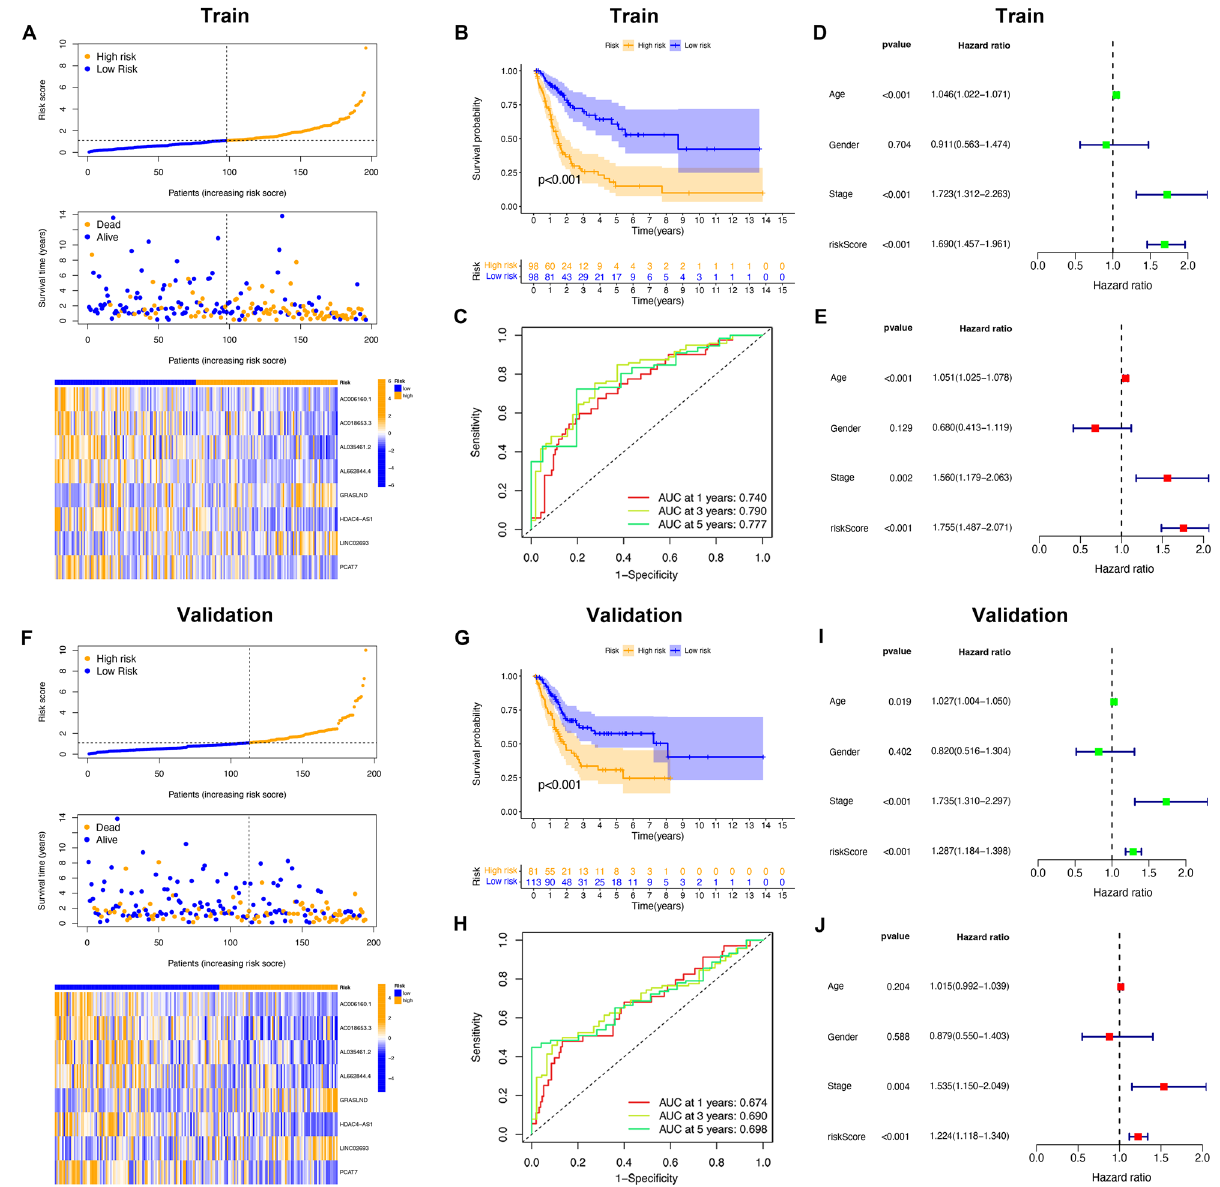
Figure 5. Internal validation of the risk signature in the TCGA database. ( A ) The distributions of risk scores and survival status in the train cohort. ( B ) Kaplan–Meier curves for the OS of patients between the high- and low-risk groups in the train cohort. ( C ) Time-dependent ROC curves for predicting 1-year, 3-year, and 5-year OS in the train cohort. ( D ) Univariate Cox regression analysis in the train cohort. ( E ) Multiple Cox regression analysis in the training cohort. ( F ) The distributions of risk scores and survival status in the validation cohort. ( G ) Kaplan–Meier curves for the OS of patients between the high- and low-risk groups in the validation cohort. ( H ) Time-dependent ROC curves for predicting 1-year, 3-year, and 5-year OS in the validation cohort. ( I ) Univariate Cox regression analysis in the validation cohort. ( J ) Multiple Cox regression analysis in the validation